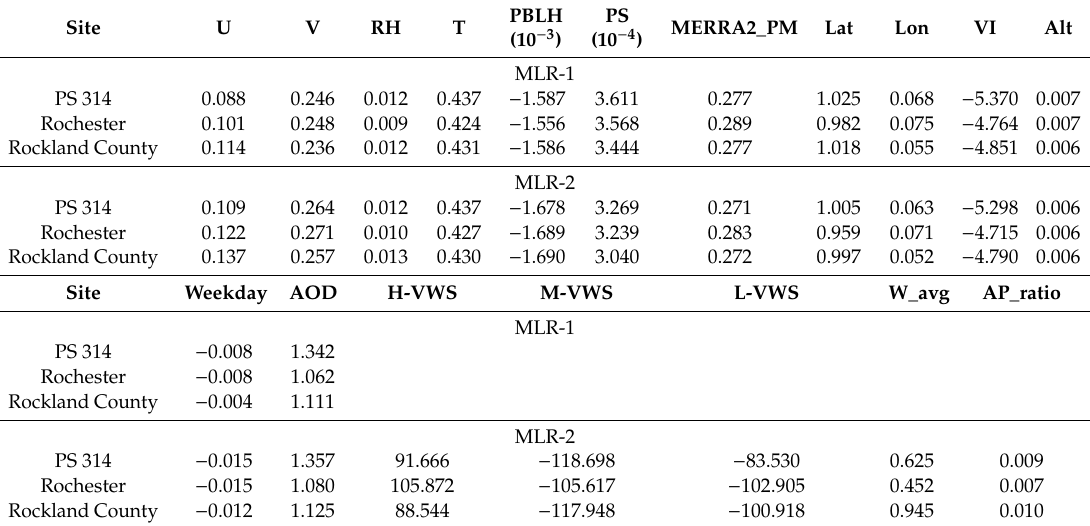
Table A4. Regression coe ffi cients from the MLR models at PS 314, Rochester and Rockland County sites.